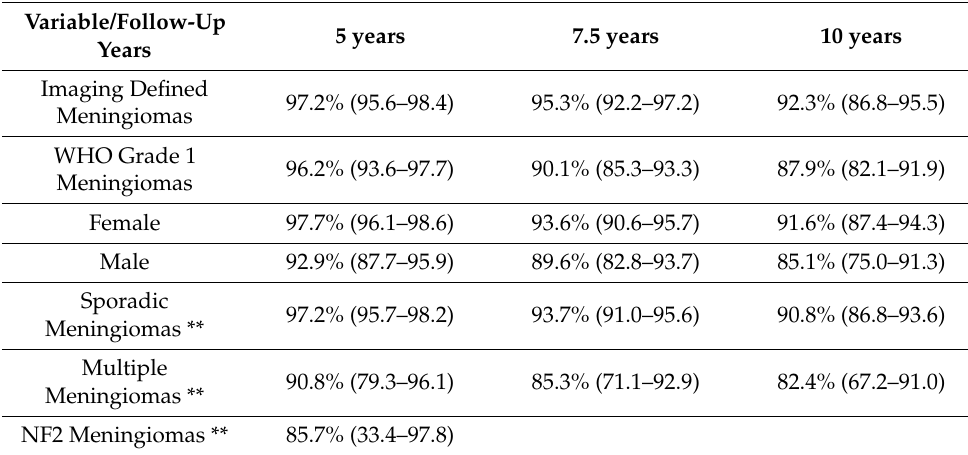
Table 4. Univariate analysis of tumour control defined as stable or reduced volume of the tumour irradiated.